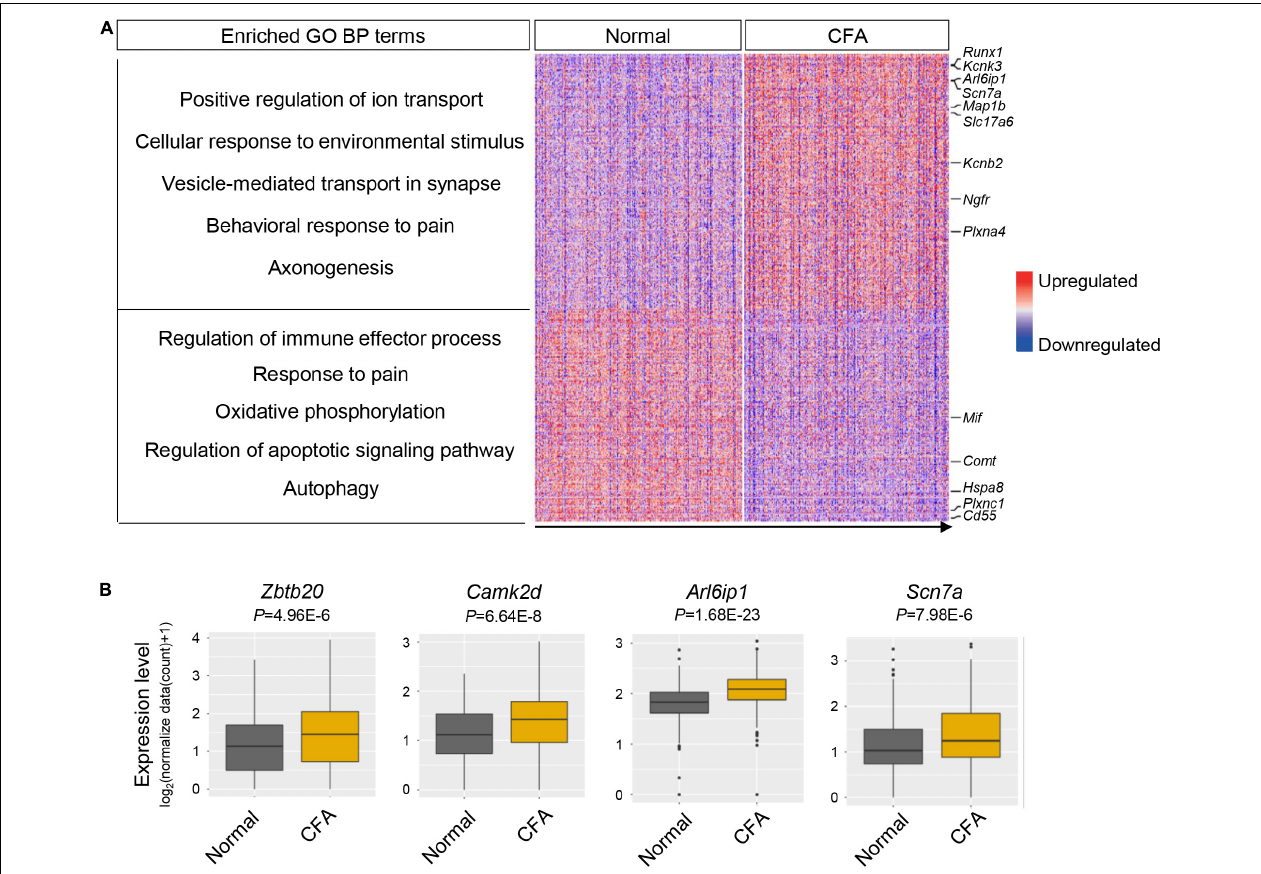
FIGURE 4 | Transcriptional alterations of overall TG neurons in response to orofacial inflammation. (A) Heatmap and enriched GO biological process terms of identified DEGs with overall TG neurons upon orofacial inflammatory pain. A total of 488 DEGs were identified, including 266 upregulated and 222 downregulated genes ( P < 0.05, log 2 | FC| ≥ 0.2, Supplementary Table 4 ). The identified DEGs were associated with the inflammatory response (such as Cd55 , Plxnc1 , and Mif ), neuronal excitability and plasticity (such as Arl6ip1 , Scn7a , Kcnb2 , and Kcnk3 ), neuroregeneration and neuroprotection (such as Ngfr , Map1b , and Plxna4 ), and mitochondrial function and autophagy (such as mt-Nd6 and Hspa8 ). Red colors indicate upregulated expression level in the heatmap, while blue colors indicate downregulated expression level. (B) Boxplots of the expression of Zbtb20 , Camk2d, Arl6ip1 , and Scn7a in overall TG neurons under normal and orofacial inflammatory pain conditions, which are likely to participate in pain modulation. TG, trigeminal ganglion; DEGs, differentially expressed genes; FC, fold change; CFA, complete Freund’s